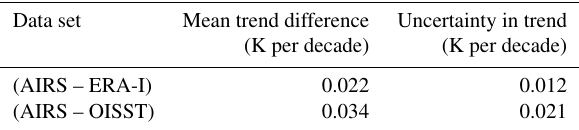
Table 7. Slope of the (AIRS − ( ERA / OISST ) ) SST anomaly differ-